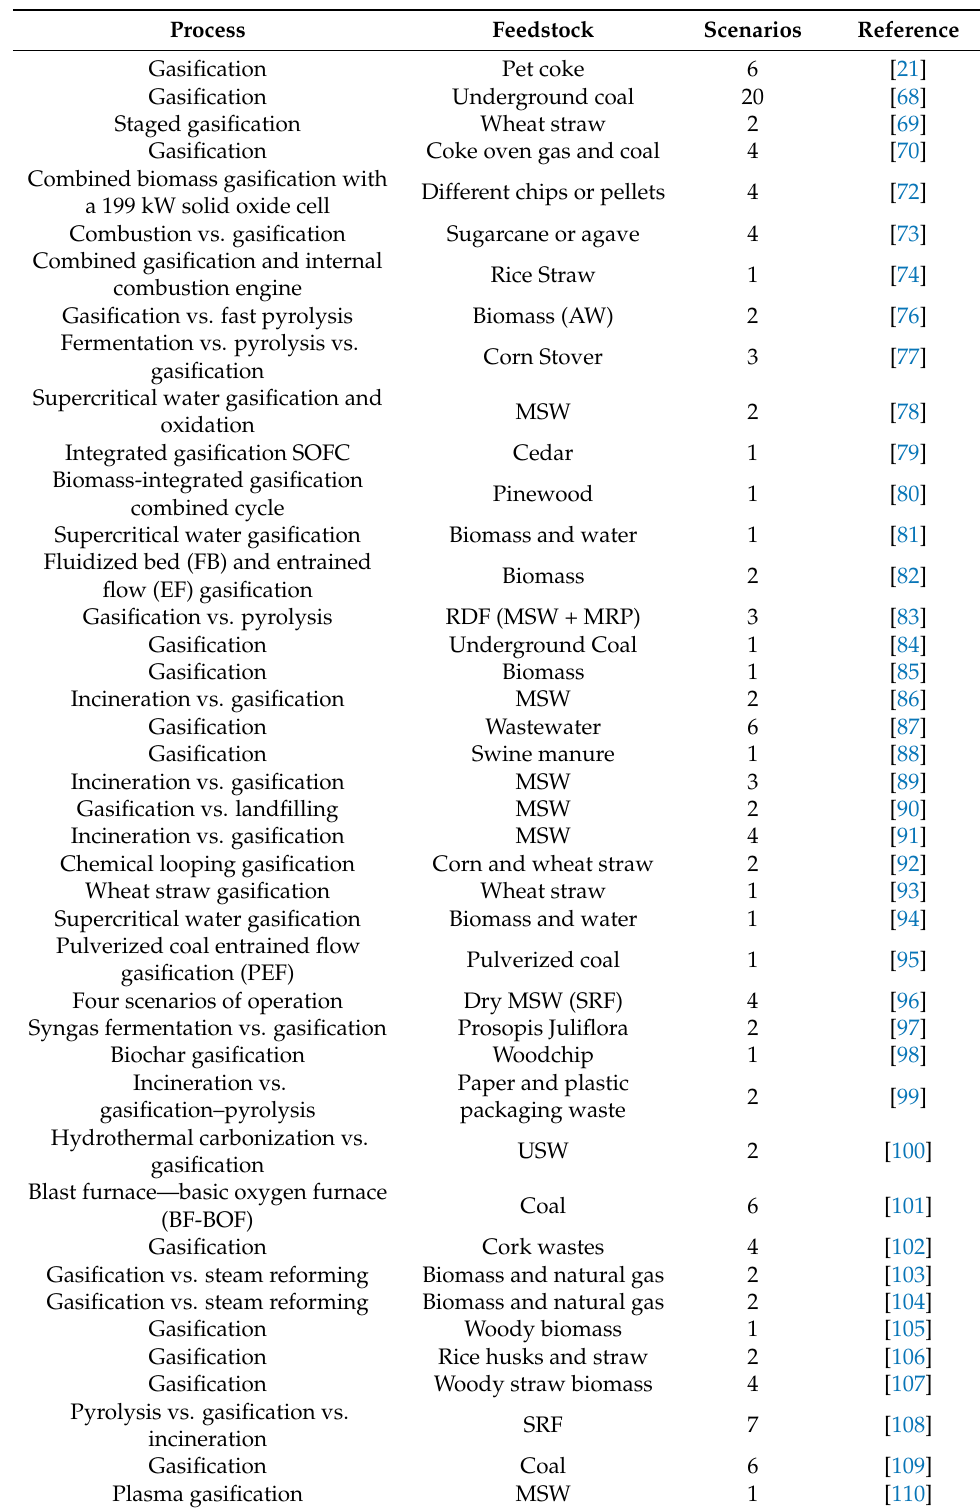
Table 7. Overview of processes, feedstock, and the number of publication scenarios in 42